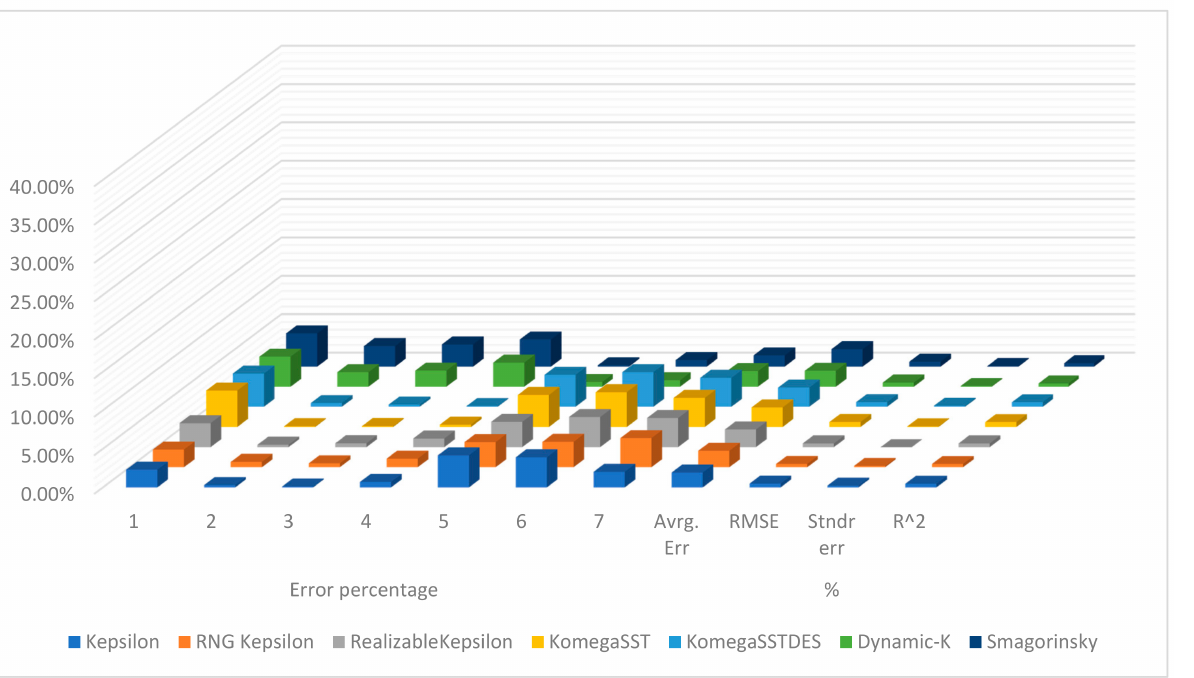
Figure 12. Errors calculated for the model results corresponding to the different turbulence models